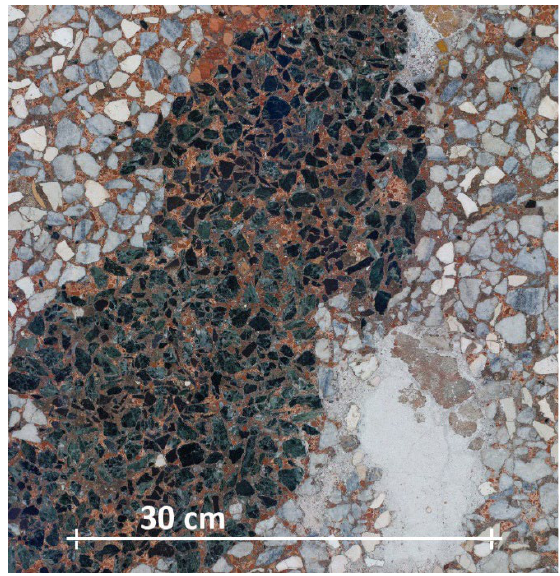
Figure 9 . detail of the orthophoto, where the single elements of the "battuto veneziano" are evident, together with the small cracks and the decay of the floor. The pixel size is 0.5 mm.